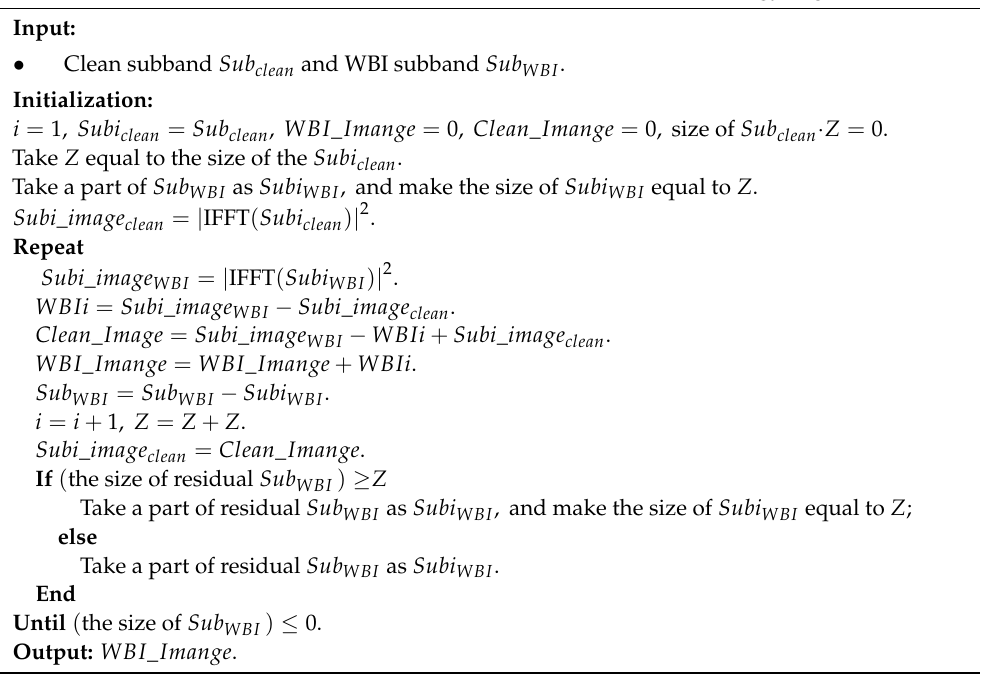
Algorithm 1 The Successive Cancellation and Data Accumulation Technology